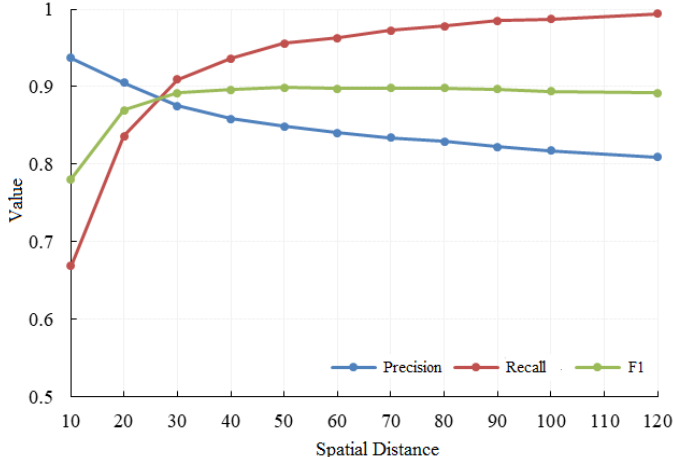
Figure 10. POI matching performance by using the spatial distance.